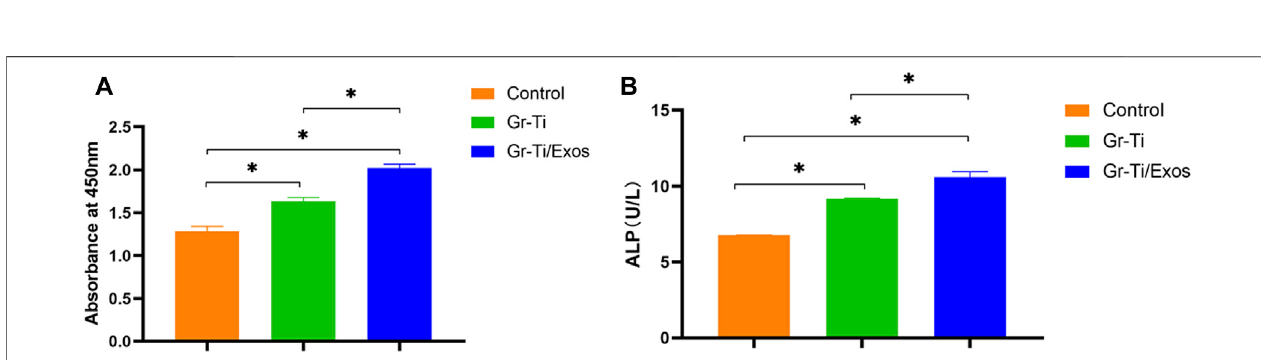
FIGURE 4 | (A) CCK-8 detection results: the number of ADSCs in the Gr-Ti/Exos group was signi fi cantly higher than that in the Gr-Ti group; (B) ALP activity test results: ALP activity in the Gr-Ti/Exos group was higher than that of the Gr-Ti group ( n = 5, p p < 0.05).